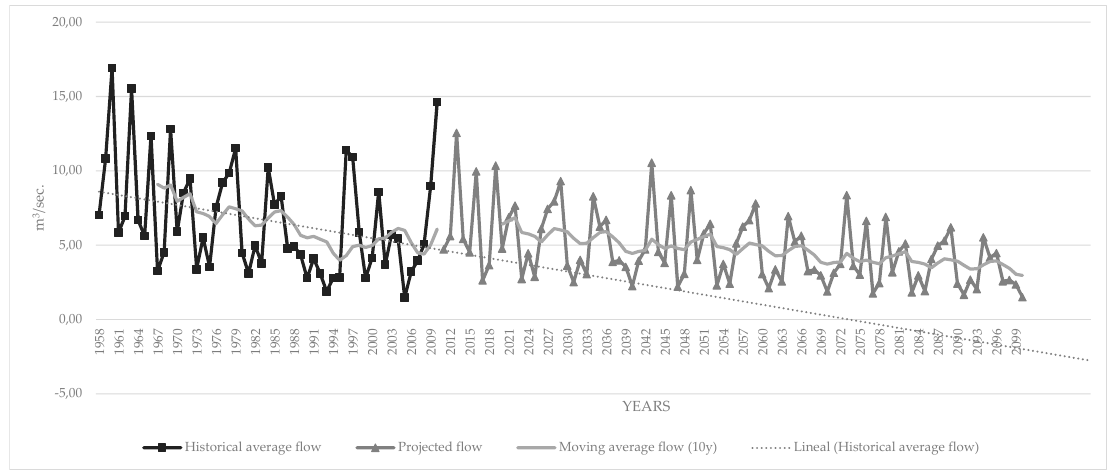
Figure 13. Historical and projected flow (m 3 /s), Tranco center. Source: Own elaboration and ENDESA.